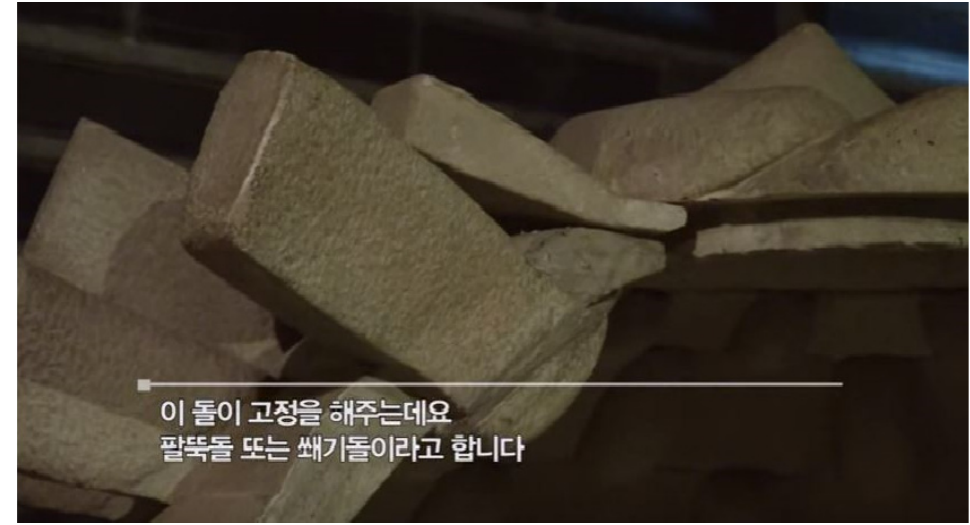
Figure 11. ‘Forearms’ that balance the horizontal and vertical forces at Seokguram’s cupola.